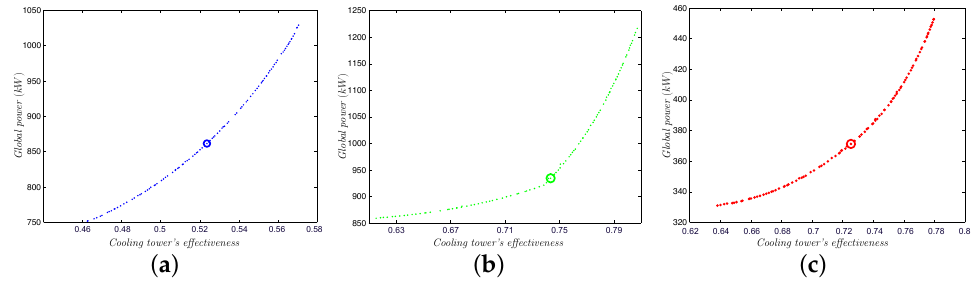
Figure 6. Pareto fronts and selected optimal solutions for 3 of the 35 operating points used in the implementation of the optimization with NSGA-II with stopping criterion after 90 s. ( a ) Operational point 8; ( b ) Operational point 16; ( c ) Operational point